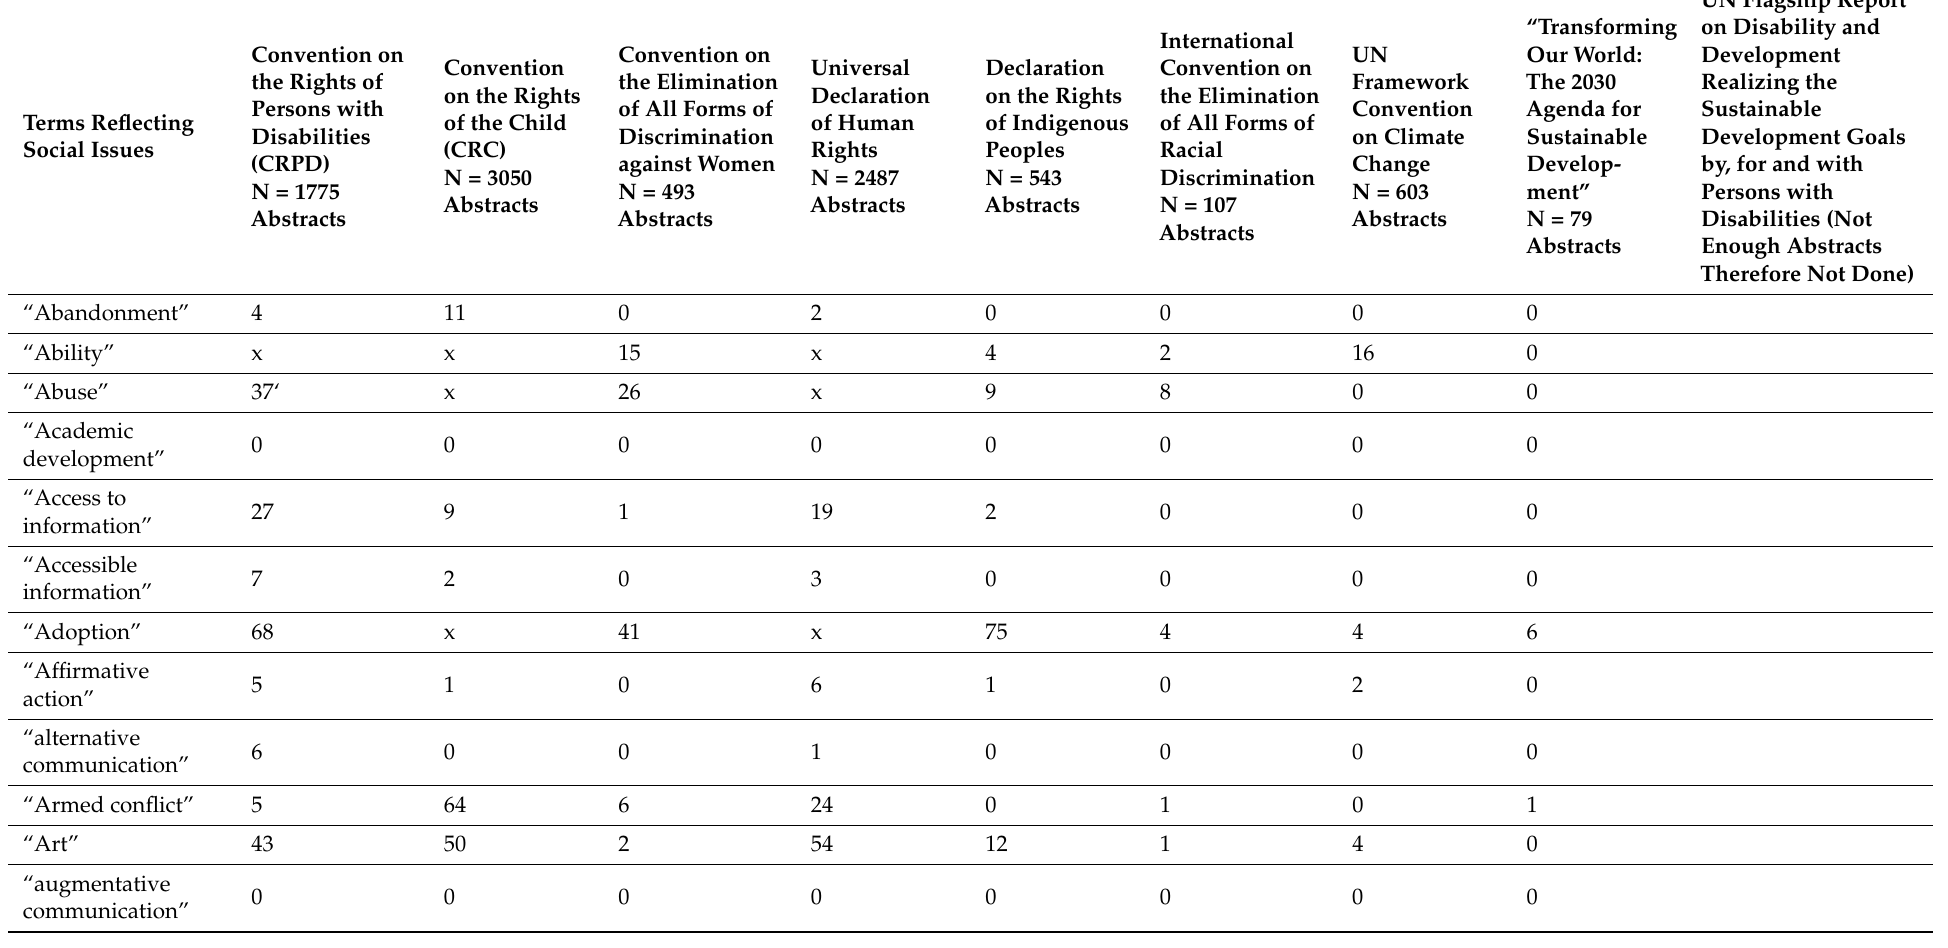
Table 16. Keywords of social issues identified from the CRPD document (Appendix A) not already in the list of the present keywords from existing literature in